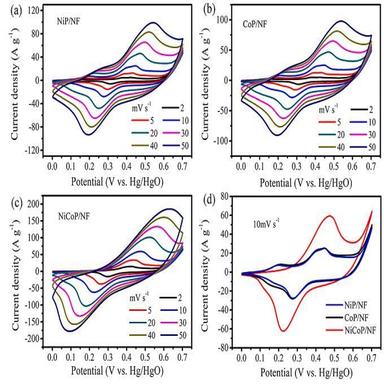
(a-c) CV curves of NiP/NF, CoP/NF, and NiCoP/NF at varied scan rates, (d) Comparison of the CV curves between NiP/NF, CoP/NF and NiCoP/NF at 10 mV s − 1 .